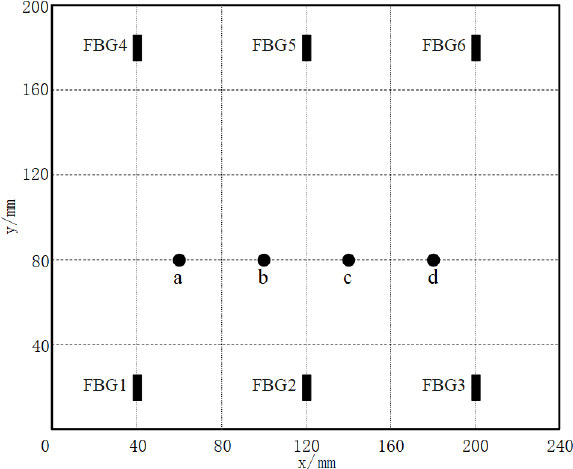
Figure 8. The impact points a–d.